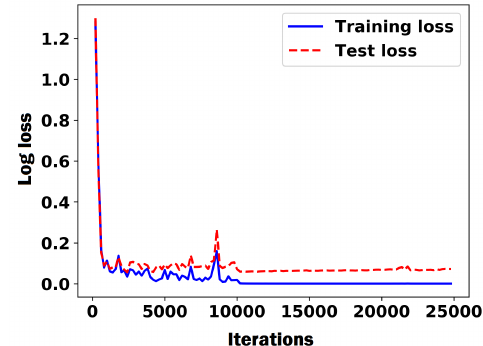
Figure 6. Plot of the log loss of the CNN classifier during training